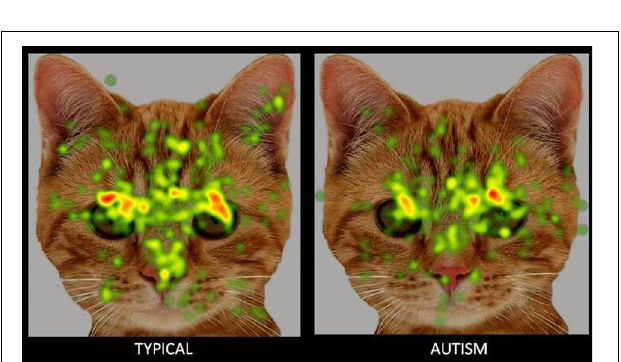
face, left eye, right eye, eye region, mouth and screen. Results